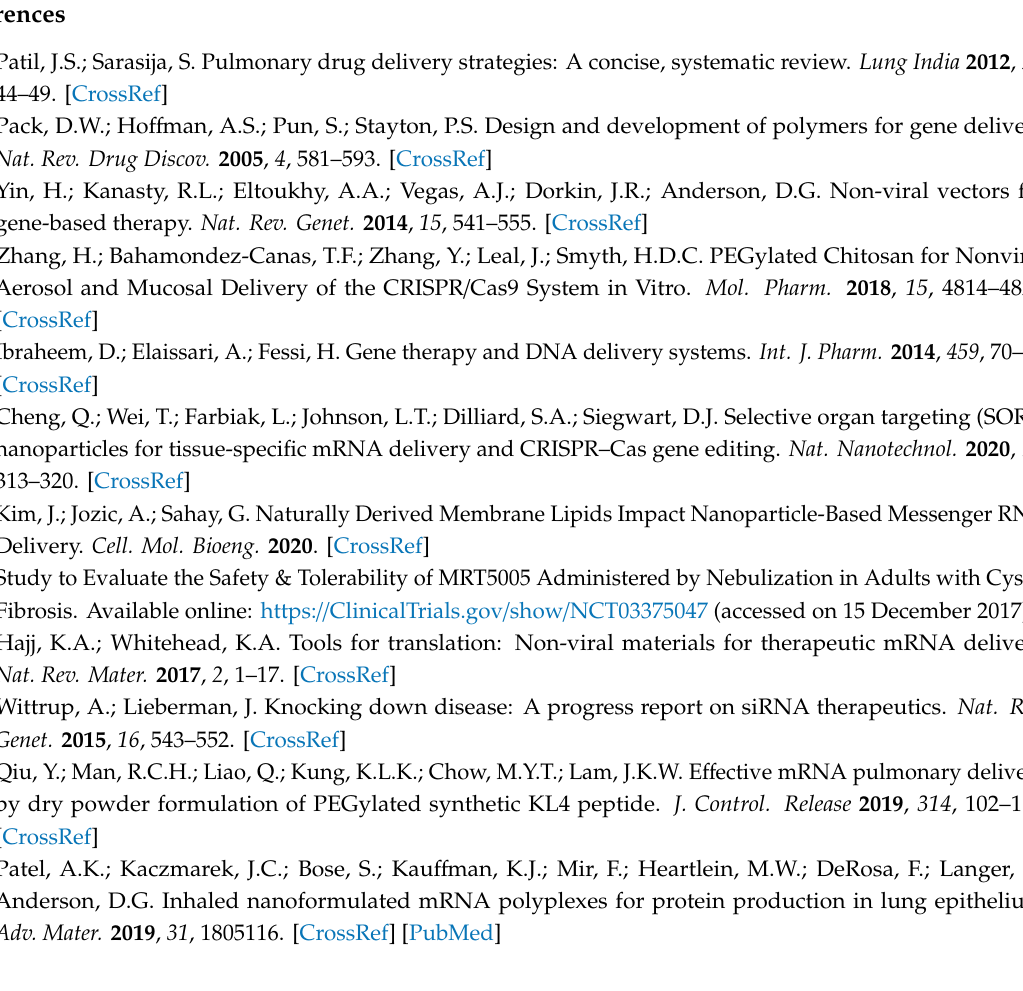
Table S1: Limits of experimental design space, Table S2: LNP compositions for 18 formulations, Table S3: PDI of pre-nebulized LNP at Day 1 and Day 14, and nebulized LNP, Figure S1: Intracellular protein expression of LNP formulations at di ff erent N / P ratios in HEK-293 cells measured by percent GFP expression (left axis) and fluorescence intensity (right axis), Figure S2: Characterization of LNP formulations. Figure S3: Significant e ff ects of type of PEG-lipid on zeta potential before (a) and after (b) nebulization, Figure S4: Correlation analysis between intracellular protein expression (percent GFP expression and fluorescence intensity) and PEG-lipid molar ratio or type of phospholipid in NuLi-1 cells. Figure S5: Representative images of the luciferase expression in lungs, heart, liver, and kidneys in negative control groups measured by IVIS